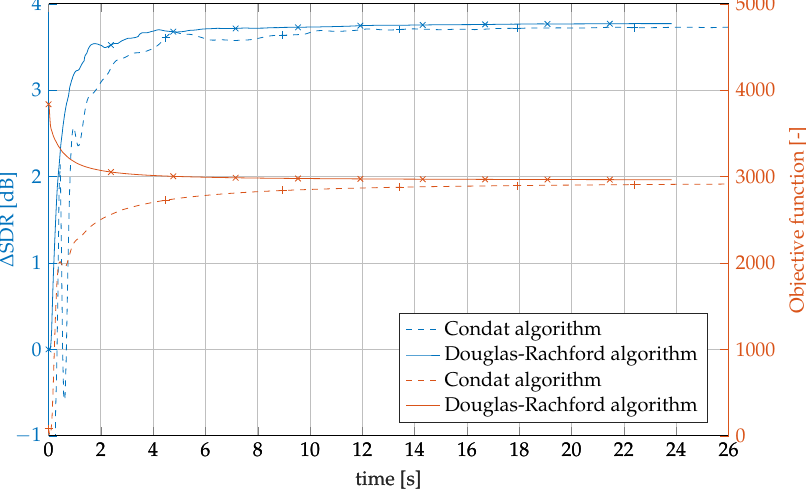
Figure 3. Analog to Figure 2, development of the ∆ SDR (blue) and objective function (orange) through iterations is shown, but now averaged over the testing sounds and the clipping thresholds. The number of iterations was